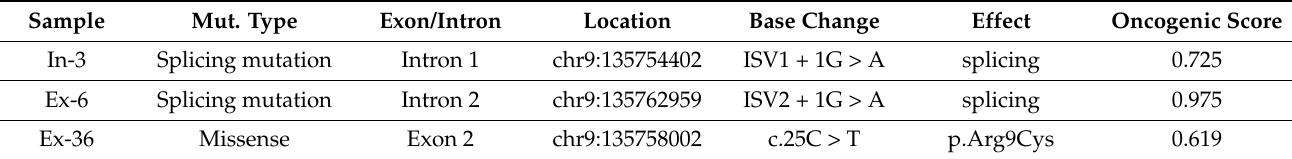
Figure 1. Exome sequencing and deep sequencing identified three somatic mutations in C9orf9 gene. In-3: patient from initial exome sequencing; Ex-6, Ex-36, patients from extended validation cohort. Somatic mutations were visualized and analyzed by SnapGene v4.2. Table 1. Novel somatic mutation of C9orf9 in CRC